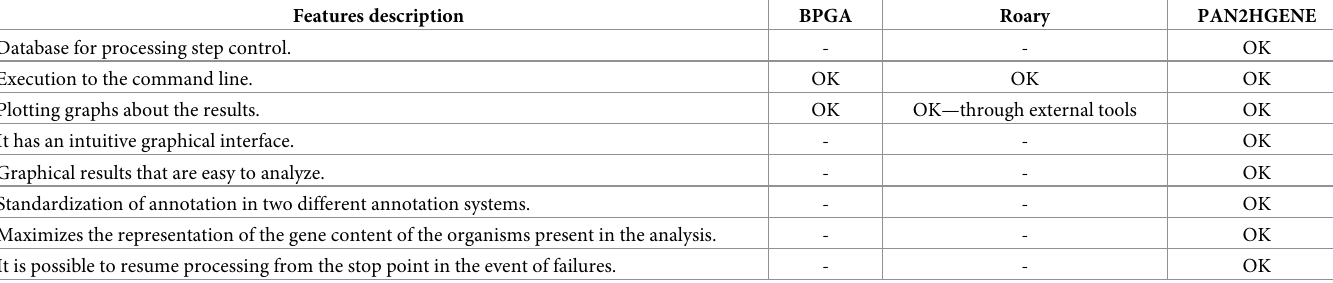
Table 3. Summary about features performed by software BPGA, Roary and